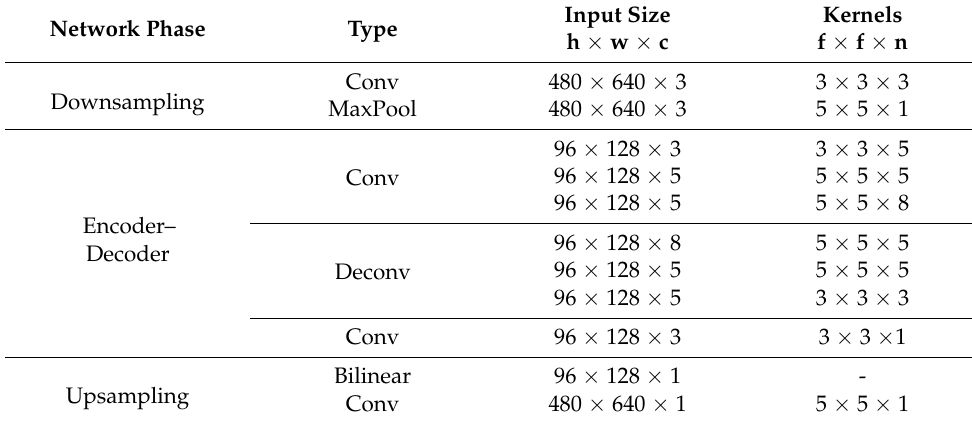
Figure 2. Symmetric architecture of TGL-Net consists of three parts: downsampling, encoder–decoder and upsampling. It is based on a condensed residual encoder–decoder structure with skip connections (dotted lines). Table 2. Architecture of the TGL-Net model.